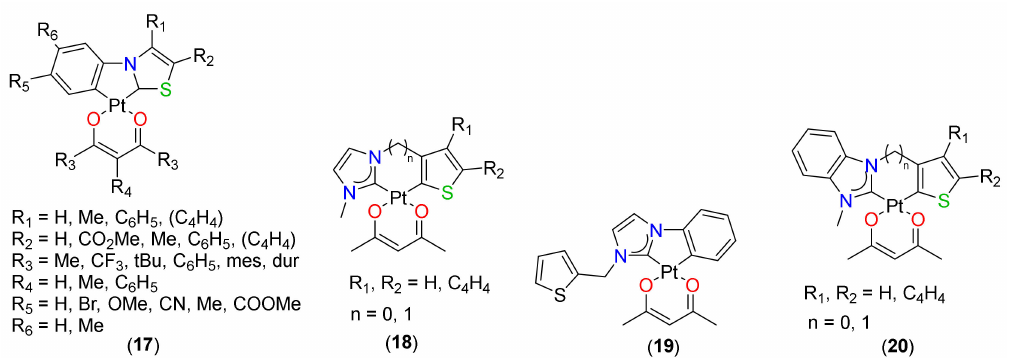
Figure 4. Pt(II) complexes based on thiazole-derived NHCs as the cyclometalating ligand and β -diketonate derivatives as ancillary